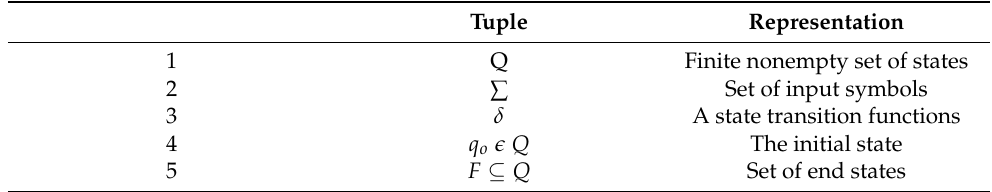
Table 2. General FSM tuple representation.